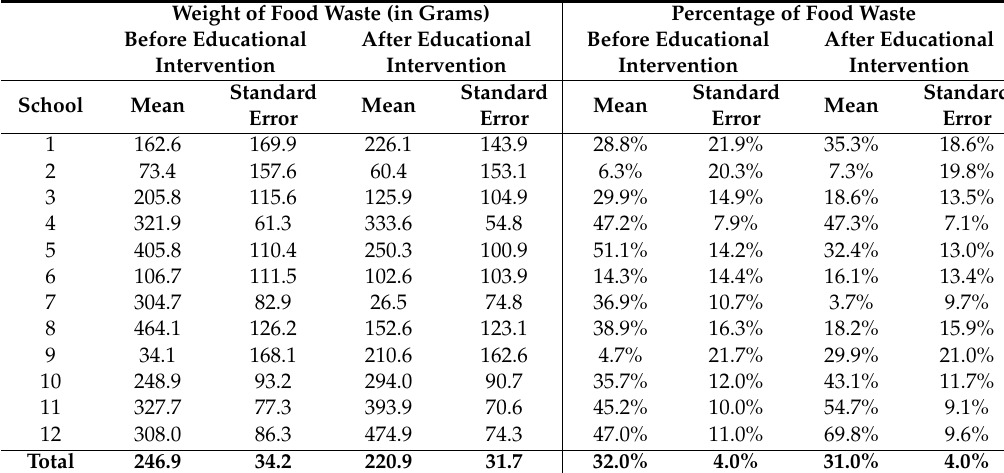
Table 2. Weights and percentages of students’ food waste from the second course before and after educational intervention. No statistically significant di ff erences were found between the 2 time points or between